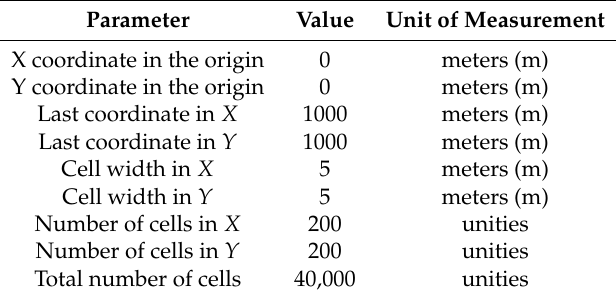
Table 1. Parameters to create the area of study.